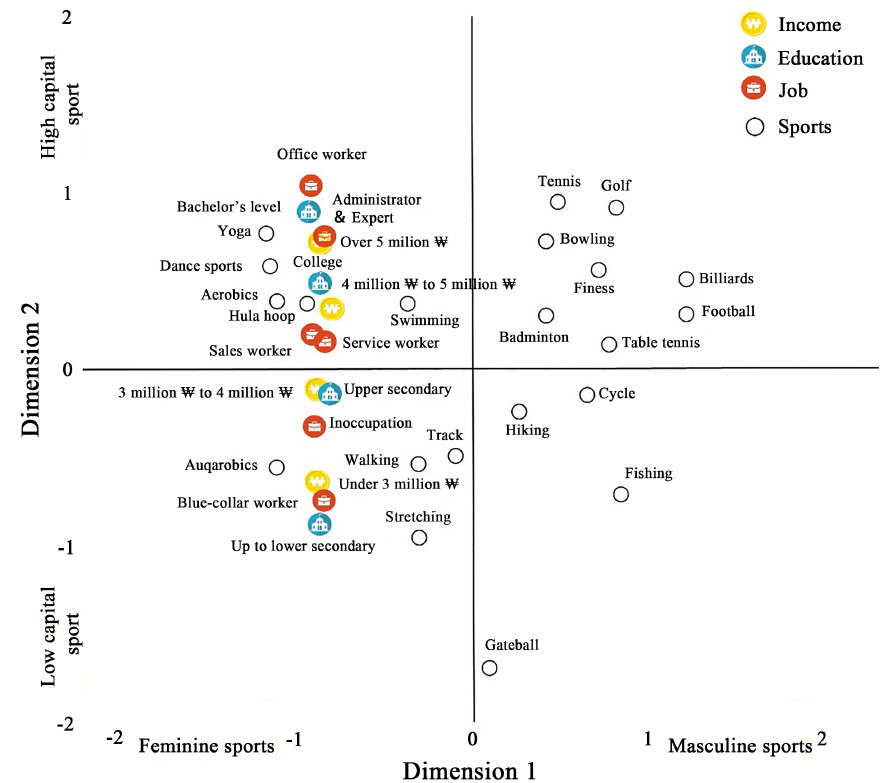
Fig. 2. MCA results of types of sports participation according to female social